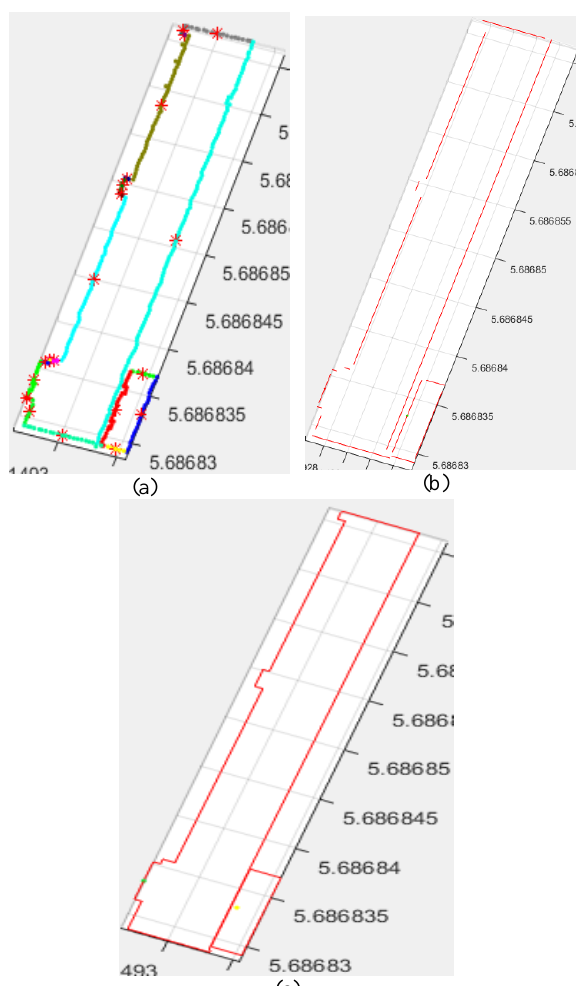
Figure 6. a) Segmented line points and their centroid points, b) Lines approximation by using the straight line equation, c) Final edges after applying regularization constraints.